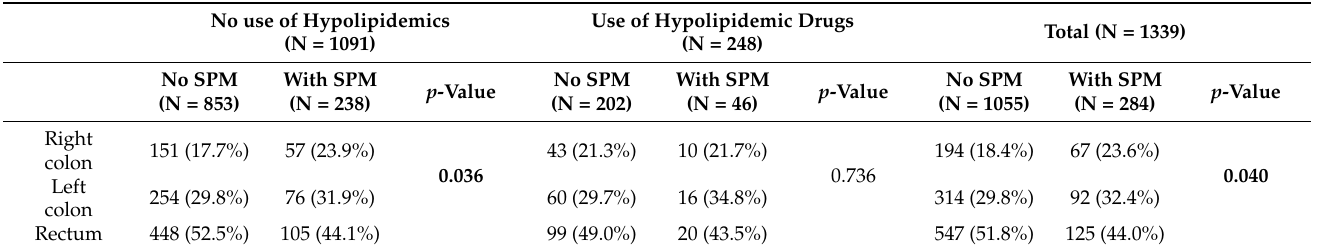
Table 5. The relationship between second primary malignancies and laterality of colorectal cancer, stratified by the use of hypolipidemic drugs and excluding patients with C18.4 (transverse colon). No use of Hypolipidemics (N = 1091)